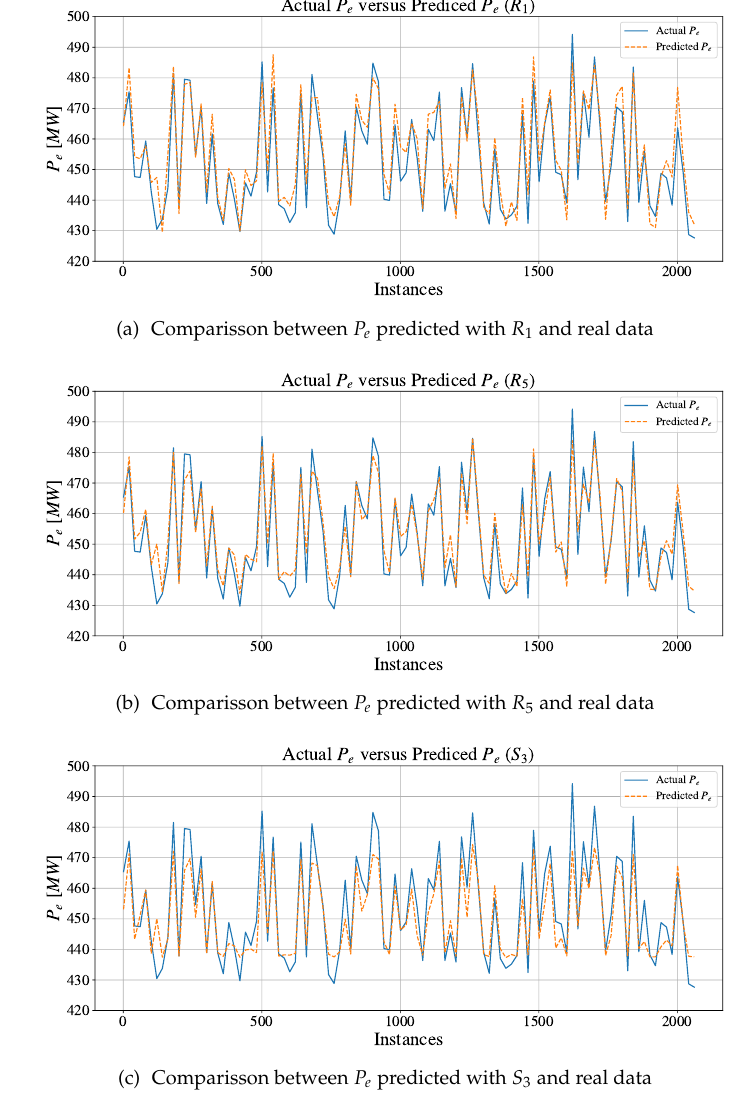
Figure 8. Comparisson between predicted P e and real data for three MLPs with the best performance: ( a ) R 1 , ( b ) R 5 and ( c ) S 3